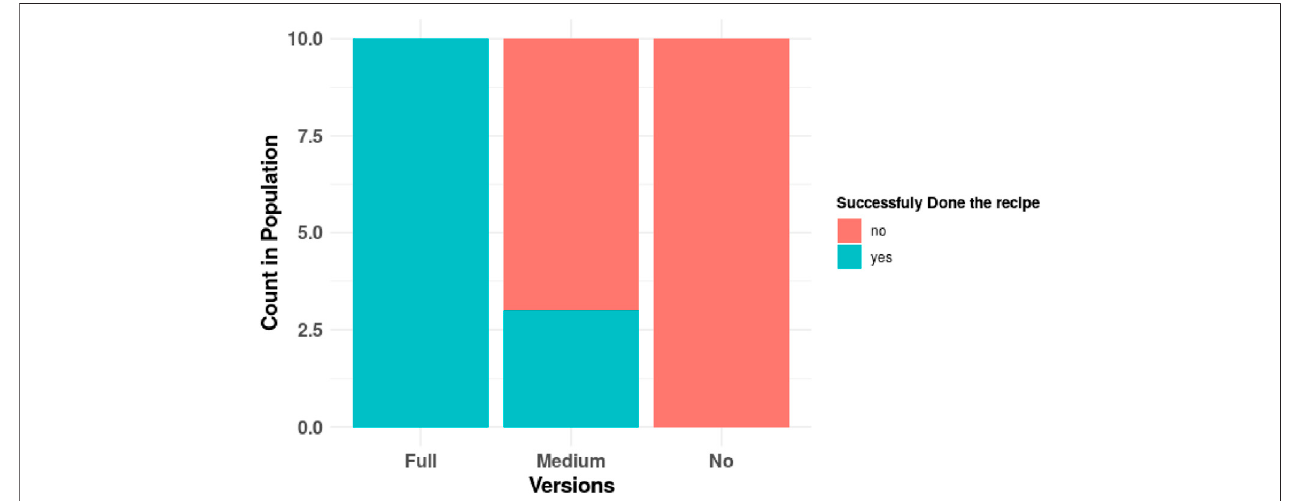
FIGURE8| Distributionofsuccessfullyachievingtoassigneddish;graphgroupsthecountsofnumberofparticipantswhoachievedtheassignedgoalsuccessfully during phase 1 to the experiment. It shows the absolute dominance of success in full proactive behavior and failure in no proactive behavior of the robot. In the medium proactive behavior of the robot, variations were observed to have success or failure.